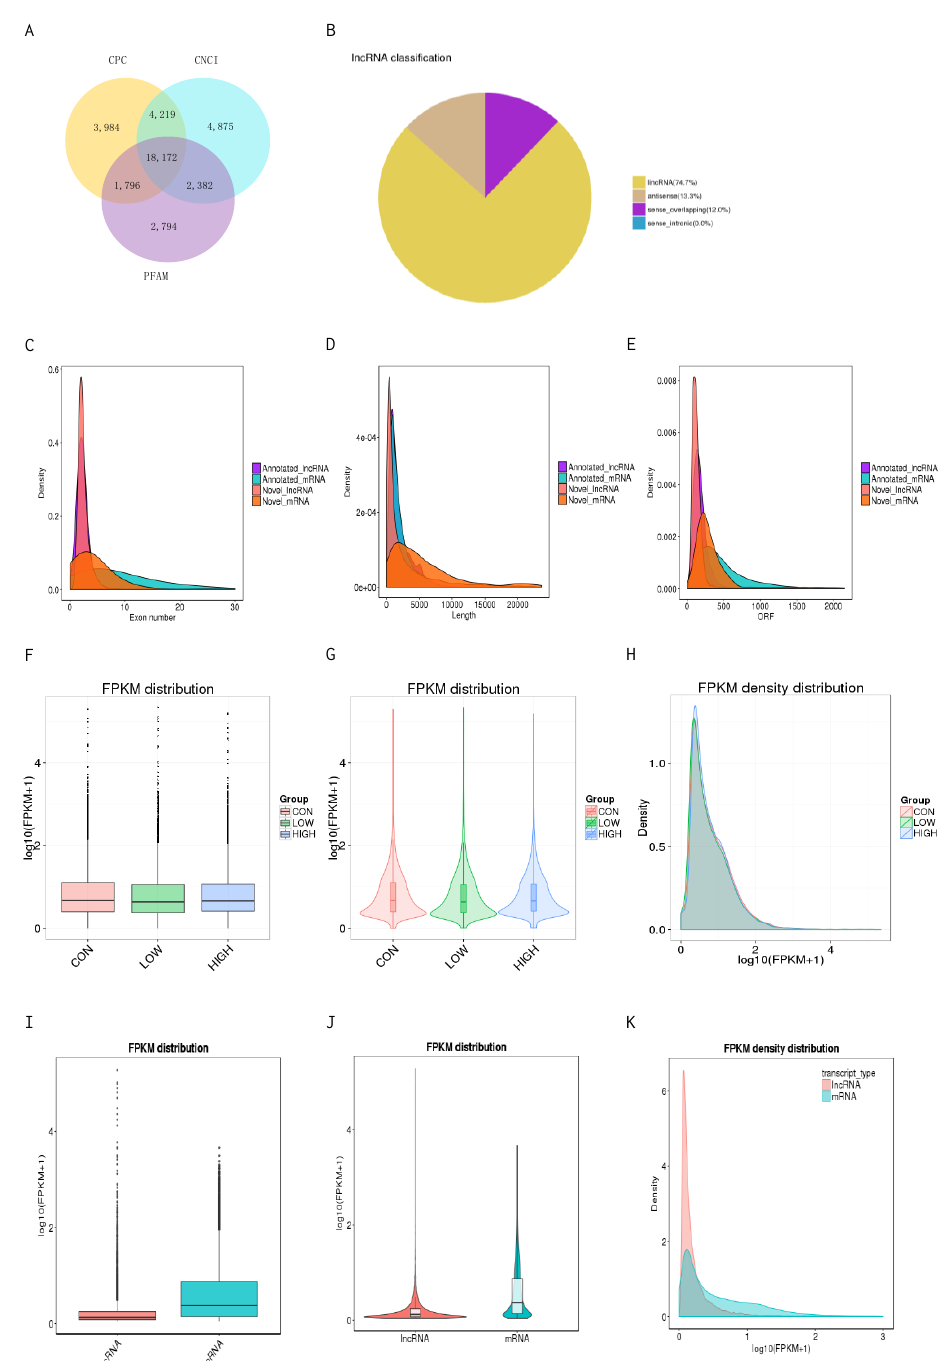
Figure 2. Characterization of long non-coding RNA (lncRNA) and mRNA in GCs. ( A ) Coding potential analysis via CNCI (Coding-Non-Coding Index), CPC (Coding Potential Calculator), PFAM (Protein Families database). Those sequences simultaneously shared by the above three tools were selected as candidate lncRNAs. ( B ) The classification of identified lncRNAs. ( C – E ) Density distribution diagram showing the expression features of exon number ( C ), length ( D ), and opening reading frame (ORF) ( E ) of annotated lncRNAs, novel lncRNAs, and mRNAs in GCs. ( F – H ) Boxplot ( F ), violin plot ( G ), and density distribution diagram ( H ) showing the expression features of GCs from in different glucose treatment groups. ( I – K ) Boxplot ( I ), violin plot ( J ), and density distribution diagram ( K ) showing the expression features of lncRNA and mRNA in ovary GCs. FPKM, fragments per kilobase